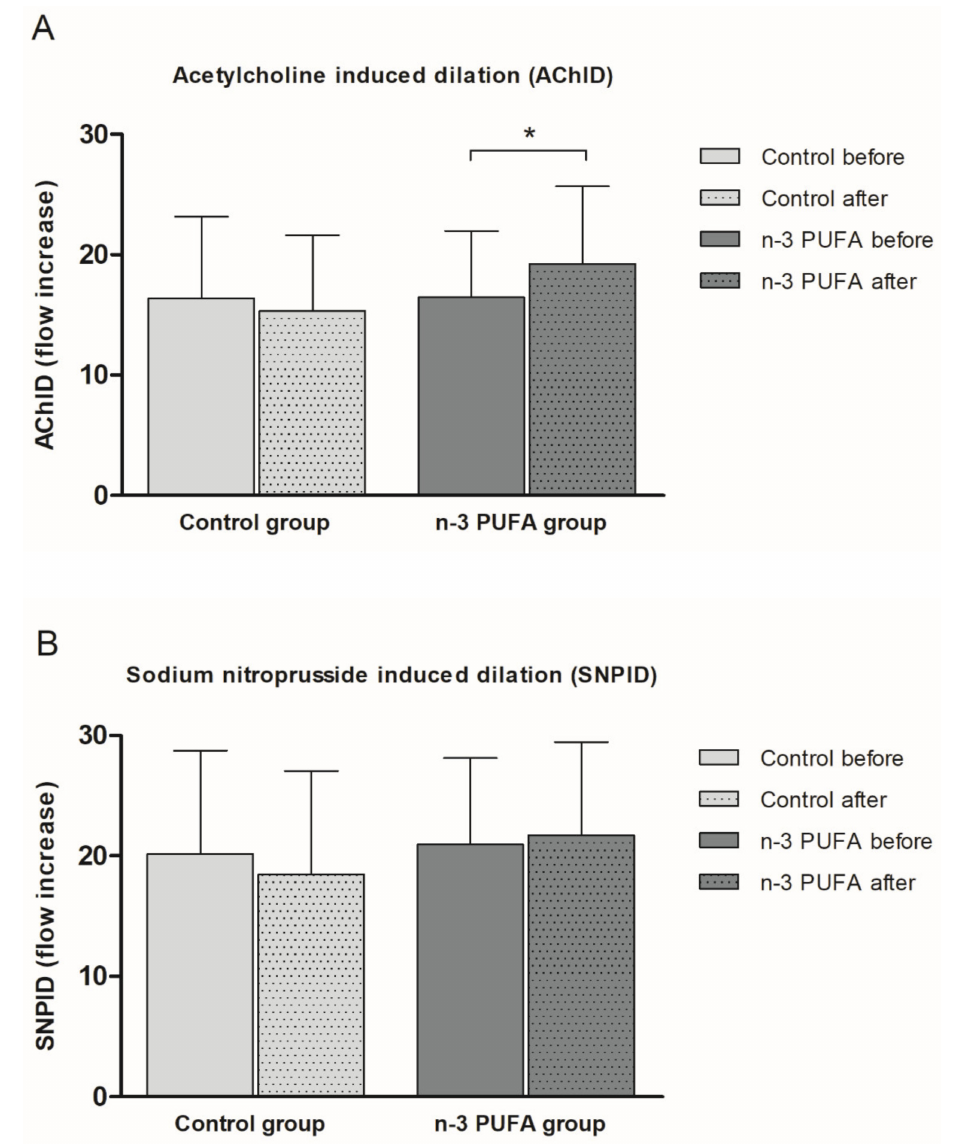
Figure2. Thee ff ectofthethree-weekregular(Controlgroup)andn-3PUFAs(n-3PUFAsgroup)enriched hen eggs consumption on skin microvascular endothelium-dependent and endothelium-independent vasodilation in young healthy individuals. ( A ) Acetylcholine-induced dilation (AChID), and ( B ) Sodium nitroprusside-induced dilation (SNPID). AChID and SNPID are expressed as flow increase following ACh or SNP administration compared to baseline flow. Data are presented as arithmetic mean ± standard deviation (SD). n-3 PUFA- n-3 polyunsaturated fatty acids. Control N = 21, n-3 PUFAs N = 19. * p = 0.014 before vs. after within the n-3 PUFA group (paired t -test). 2.6. Serum Pro- and Anti-Inflammatory Cytokines, Chemokines, Growth Factors, and Soluble Cell Adhesion Molecules Protein Concentration Serum pro- (INF γ , TNF- α , IL-17A, IL-6, IL-23, and IL-9) and anti-inflammatory (and immunomodulatory) cytokines (IL-21, IL-22, and IL-10), chemokines (SDF-1 α ), LAP, vascular growth factors (VEGF-A, VEGF-D) and soluble cell adhesion molecules (sICAM-1, sVCAM-1), protein concentration values in the Control and n-3 PUFAs group before and after respective protocol are described in Table 6. INF γ protein concentration significantly decreased, and IL-10 serum concentration significantly increased following consumption of n-3 PUFAs enriched eggs compared to baseline measurement within the n-3 PUFAs group. Serum protein concentration of other measured